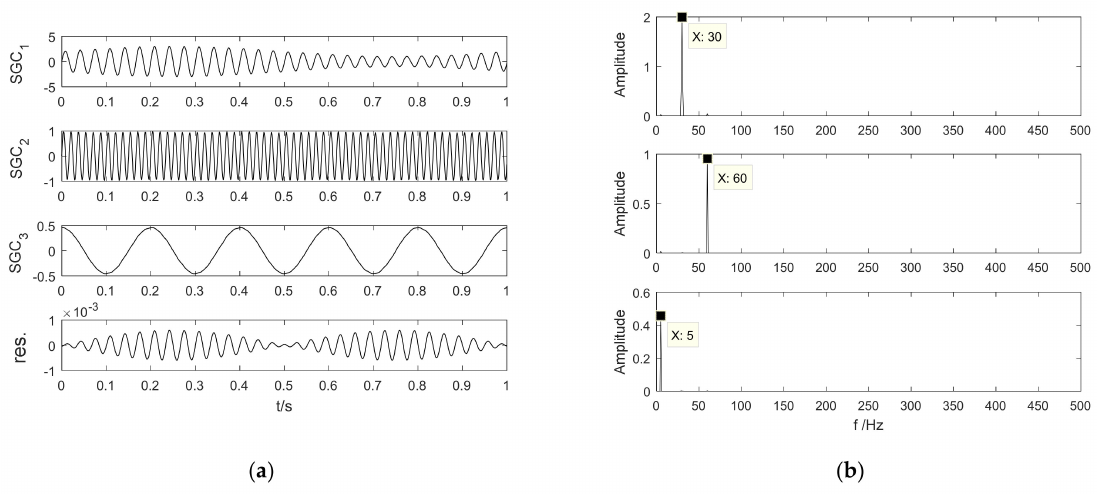
Figure 3. The decomposition results of SGMD-CS. ( a ) Time domain; ( b ) Frequency